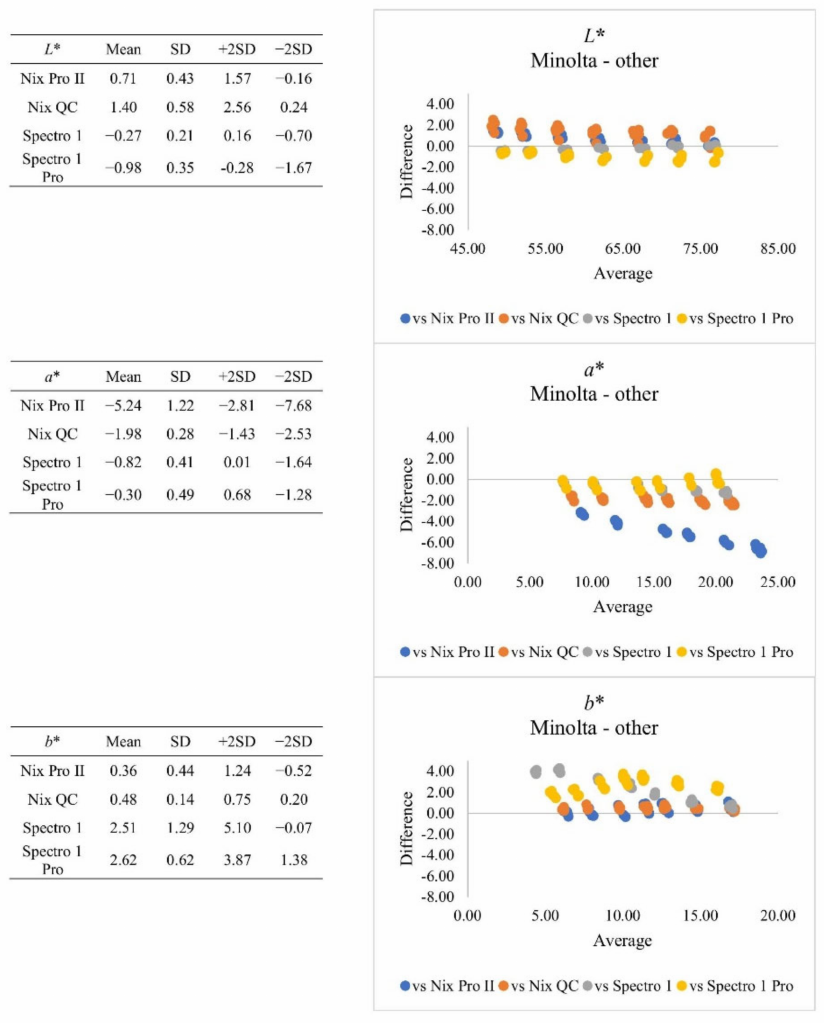
Figure 1. Plot of differences between Minolta and other instruments when Canadian colour standards were measured. SD = standard